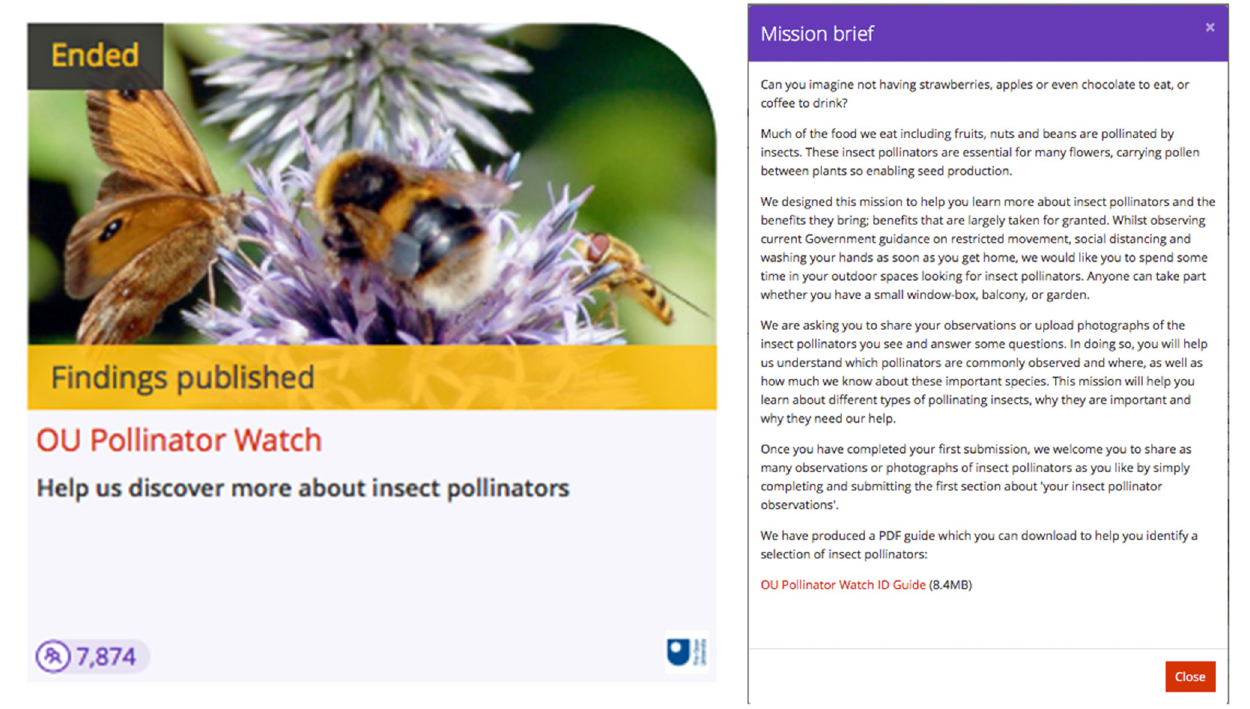
FIGURE 5 | The mission brief of the Pollinator Watch investigation on